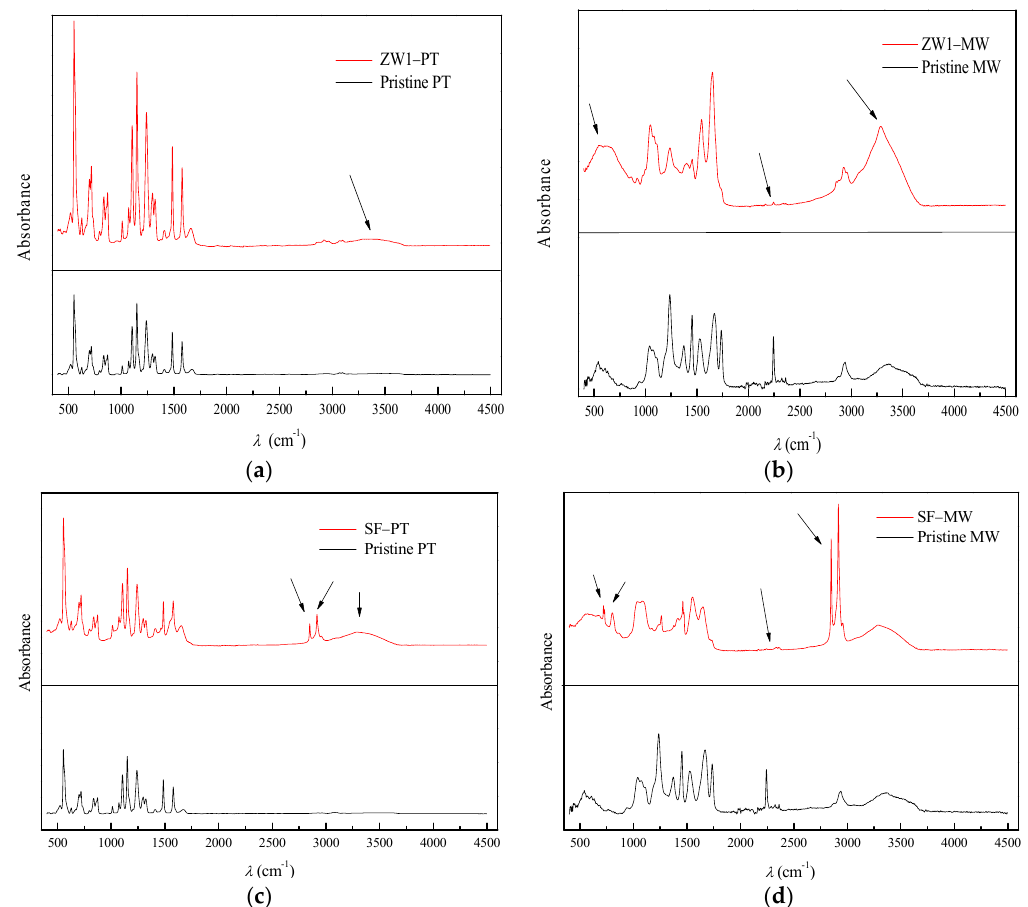
Figure 4. FTIR spectra of pristine and membranes after treatment: ( a ) ZW1-PT, ( b ) ZW1-MW, ( c ) SF-PT, and ( d ) SF-MW. Table 3. Peak position and functional groups of fouled and pristine membranes.